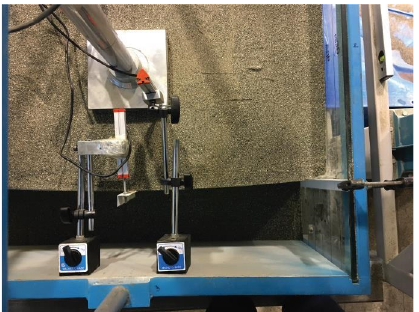
Figure 6: State of SPW before load start – 1.